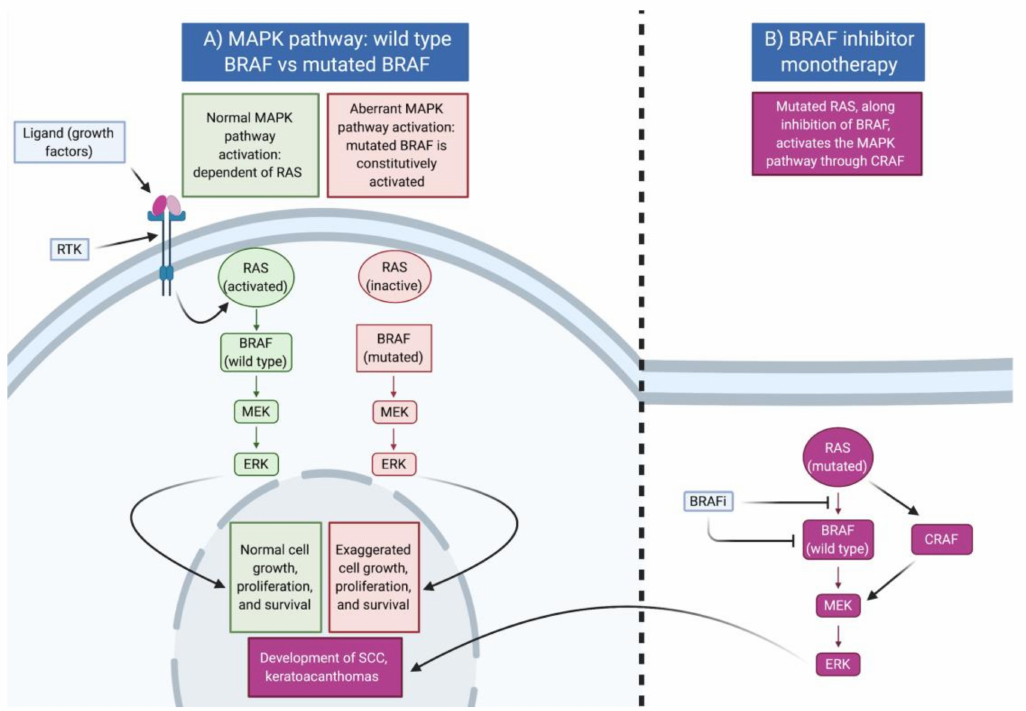
Figure 1. Overview of the MAPK pathway. ( A ) MAP kinase pathway in the settings of wildtype BRAF and mutated BRAF . In the presence of a BRAF mutation, inappropriate constitutive activation of the pathway occurs, leading to cell proliferation. ( B ) In the presence of BRAF inhibitor monotherapy, paradoxical activation of the MAP kinase pathway occurs through mutated RAS and CRAF , an isoform of BRAF . SCC : squamous cell carcinoma; RTK: receptor tyrosine